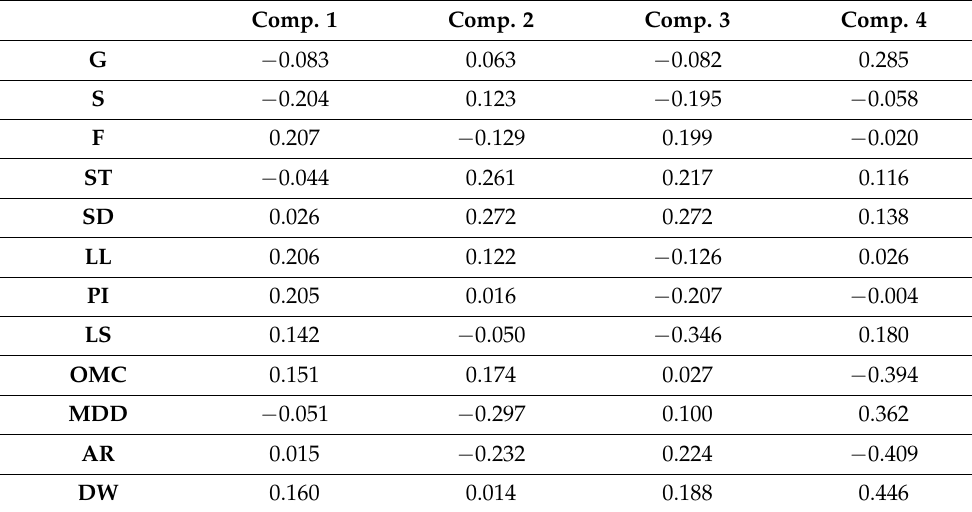
Table 8. PCA developed